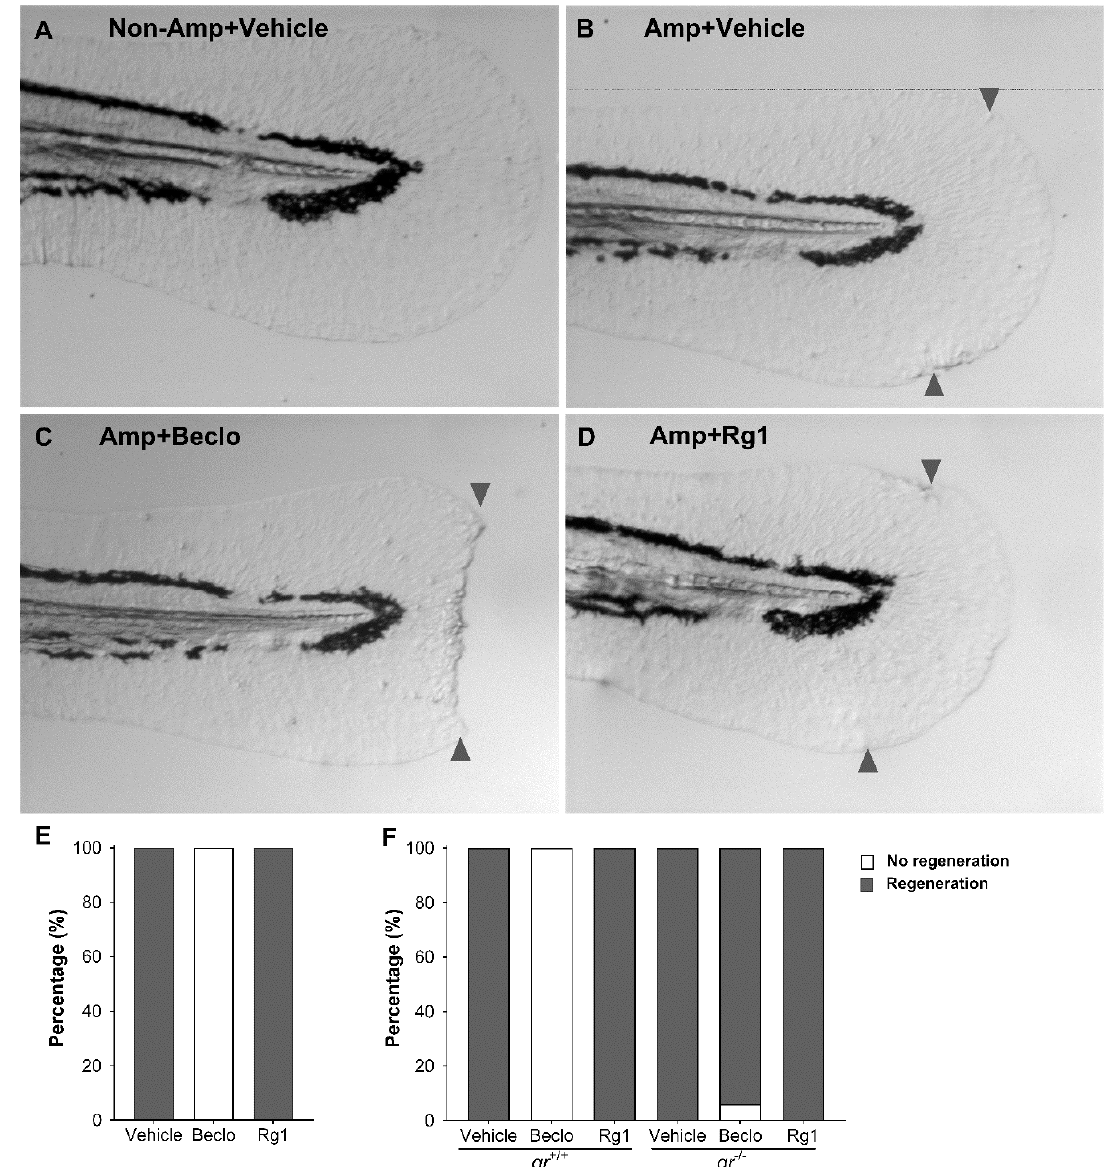
Figure 5. E ff ects of beclomethasone and Rg1 on the regeneration of the tail fin. ( A – D ) Representative images of the tail fins of zebrafish larvae at three days after amputation (Amp) or without amputation (Non-Amp) and treated with vehicle, beclomethasone (Beclo), or Rg1. The approximate location of the amputation site is indicated with arrowheads on the dorsal and ventral side of the tail fin. The images show full regeneration of the tail fin in the vehicle and Rg1 treated larvae, and a total lack of regeneration in the Beclo group. ( E ) Quantification of the tail fin regeneration in zebrafish larvae treated with Vehicle, Beclo, or Rg1 ( n = 90 larvae per group, accumulated from three independent experiments. ( F ) Quantification of the tail fin regeneration in Gr mutant ( gr − / − ) and control ( gr +/+ ) larvae treated with vehicle, Beclo, or Rg1 ( n = 90 larvae per group, accumulated from three independent